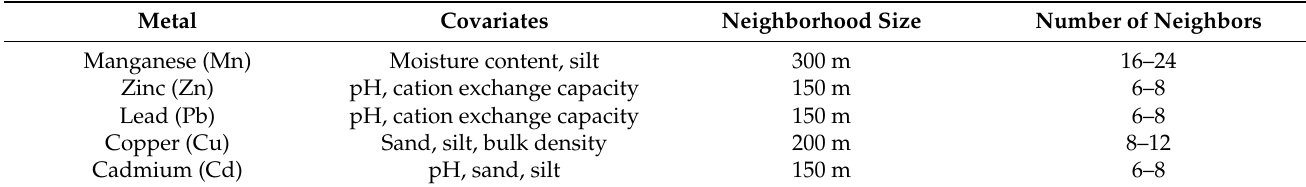
Table 1. Summary of spatial regression model output used to inform choice of cokriging variables and settings